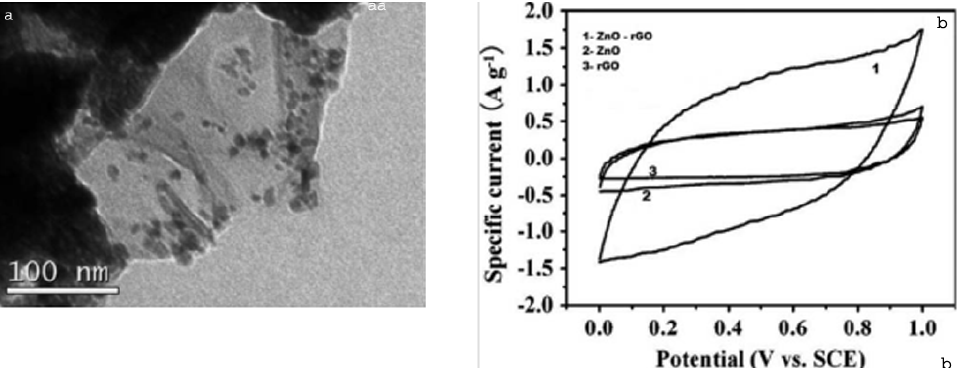
Fig. 6. (a) TEM images of ZnO/rGO composites, (b) The CV curves for ZnO, rGO, and the ZnO/rGO composite are electrodes in 0.1MNa SO electrolyte at the sweep rate of 5 mV/s, reprinted with permission 2 4 of Ref. [56] Copyright 2014 Taylor & Francis.